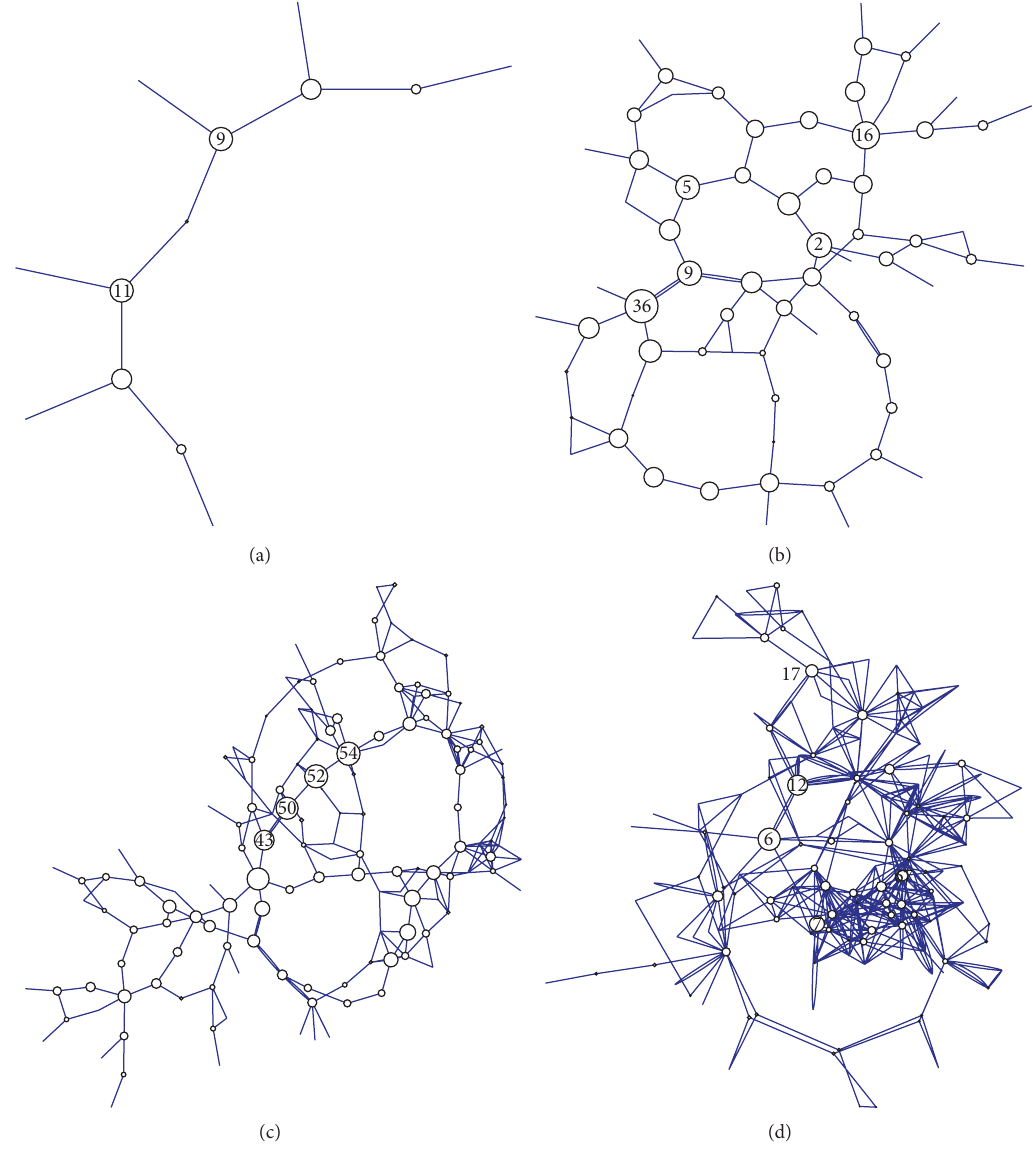
Figure 8: Multigraphs of the test power grids (a) G 4 , (b) G 16 , (c) G 48 , and (d) G 50 .